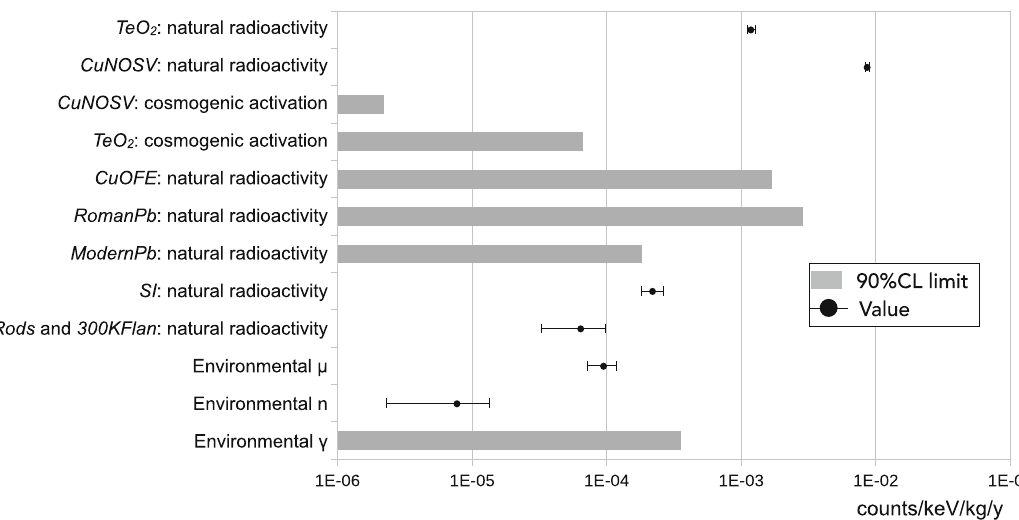
Fig. 6 Histogram representing the main BI expected for the various components of CUORE. The grey bars indicate 90% C.L. upper limits while the dots (with 1 σ uncertainties) indicate derived values. Only statistical uncertainties are indicated